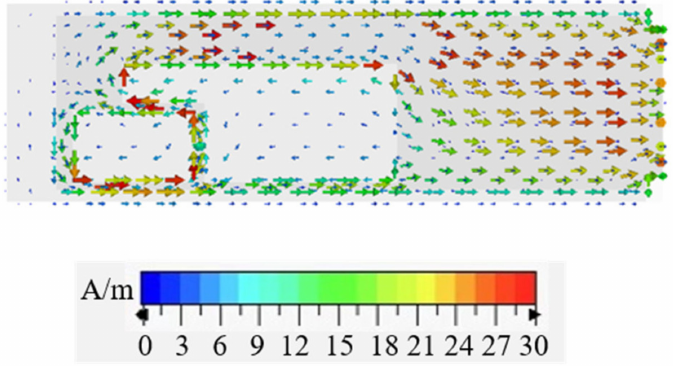
Figure 7. Simulated surface electrical current distribution of the antenna at 920